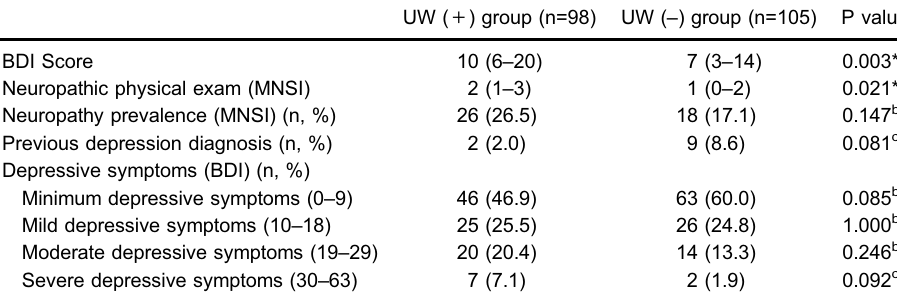
Table 3. Scores for depression and neuropathic symptoms of 203 patients with type 2 diabetes mellitus assessed for the presence of the symptom of unsteady walking (UW).